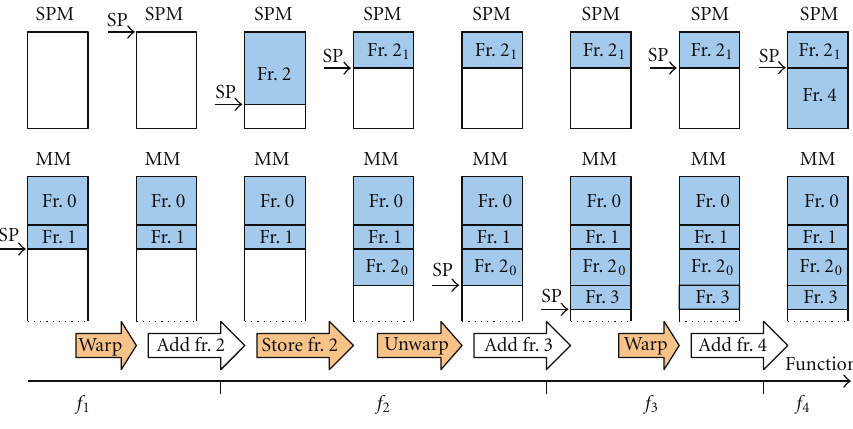
Figure 8: Proposed management with two